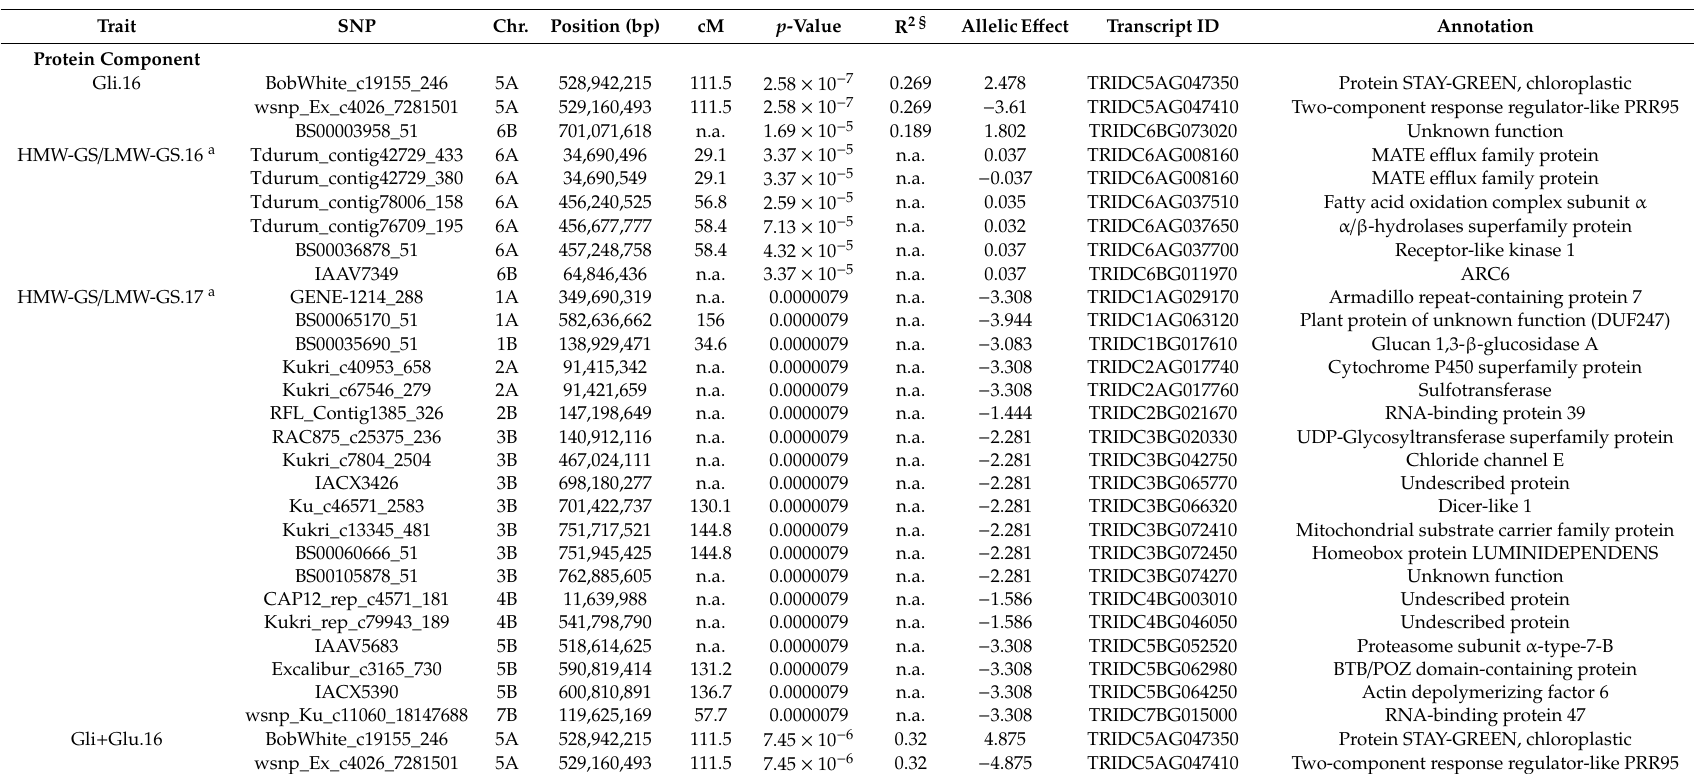
Table 1. Marker trait association for gluten component (Gli, HMW-GS, and LMW-GS) and CD-related peptide traits. SNP nomenclature, chromosome position, transcript ID, and annotation derive from the ‘Zavitan’ genome (WEWSeq v.1.0). Trait SNP Chr. Position (bp) cM p -Value AllelicE ff ect Transcript ID Annotation Protein Component